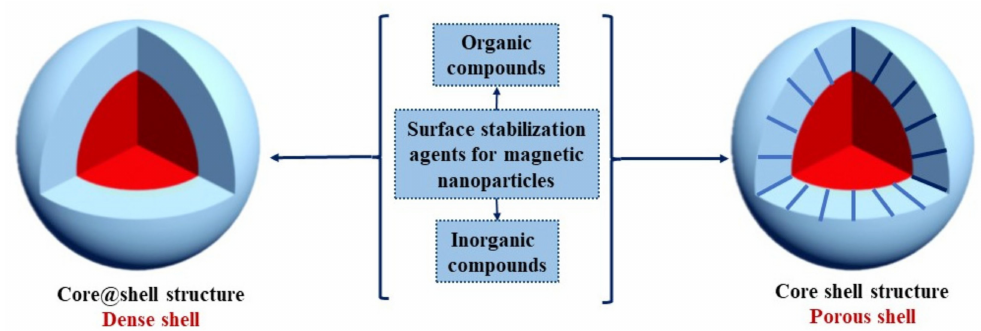
Figure 2. Surface stabilization protocols in developing porous versus non-porous core@shell mag- netic